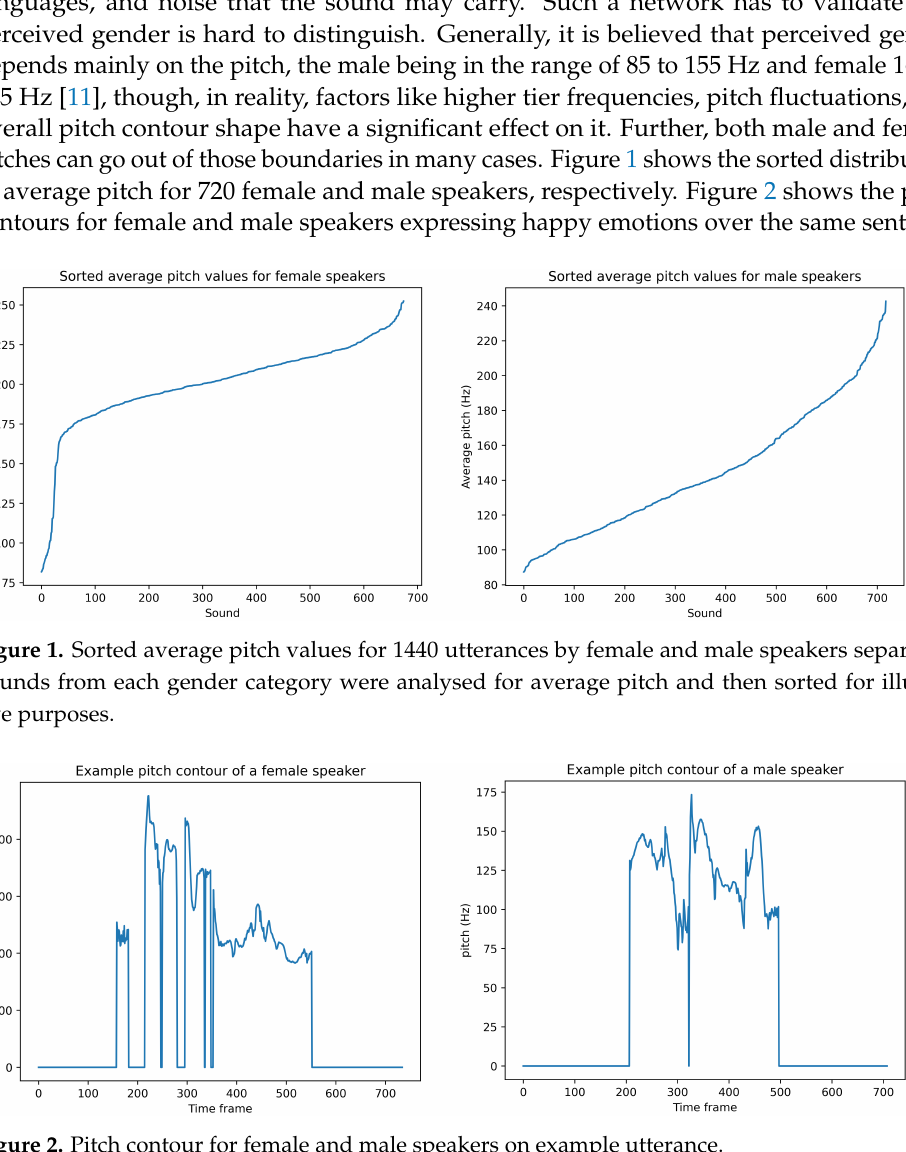
Figure 2. Pitch contour for female and male speakers on example